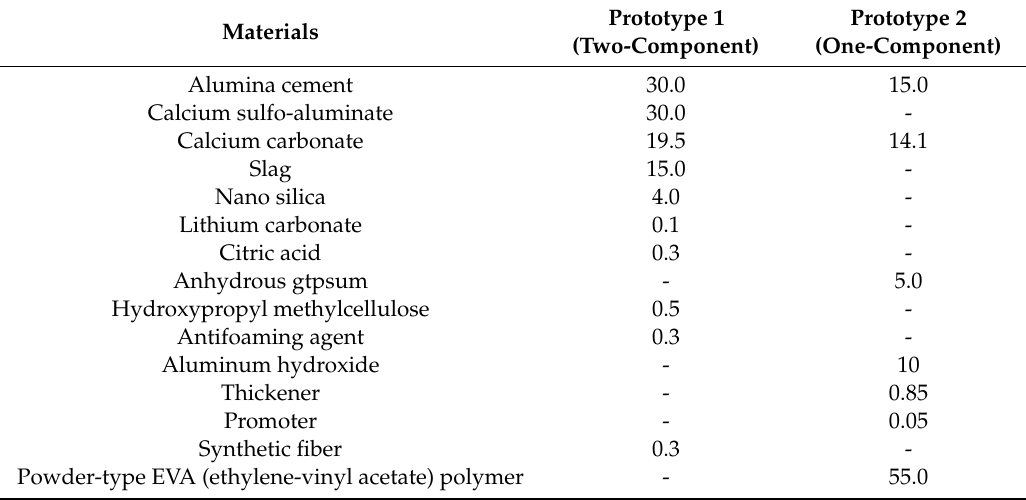
Table 1. Chemical composition of the sprayed waterproof membrane (weight %) [11].